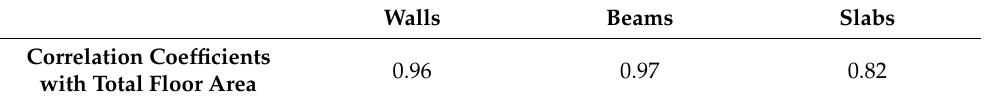
Table 10. Correlation analysis between the amount of rebar and total floor area by members.